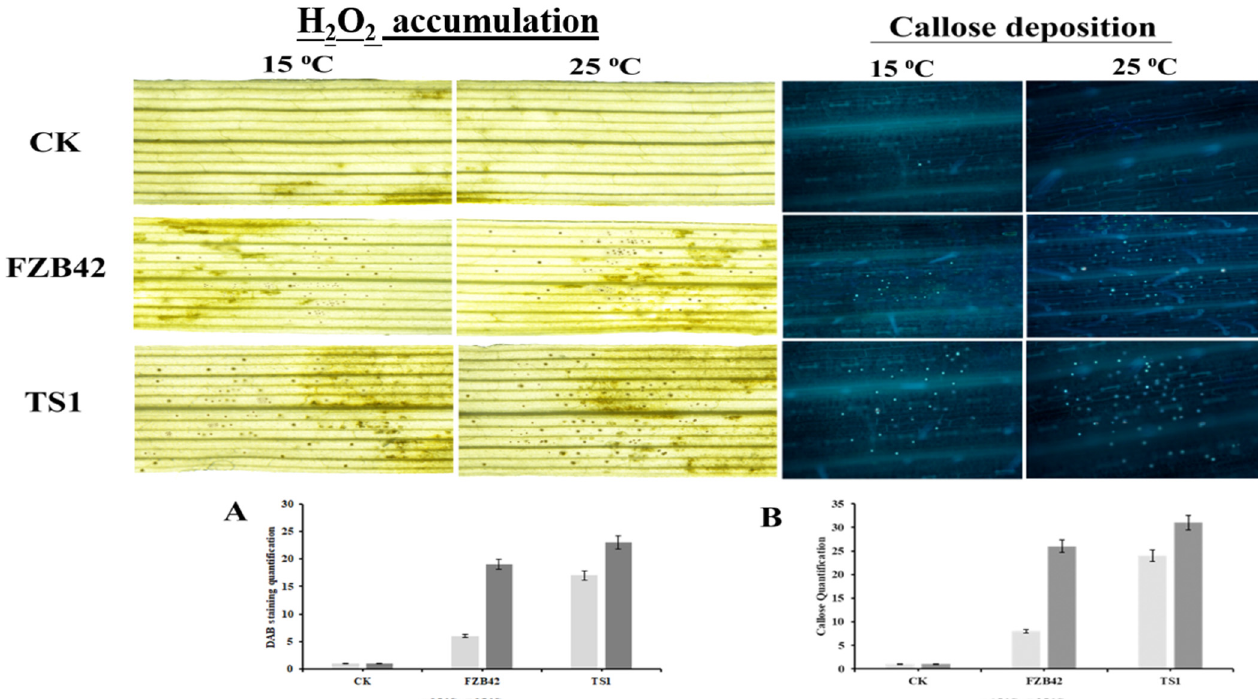
Figure 7. ( A ) The H 2 O 2 accumulation indicated by brown spots as observed by light microscopy in wheat leaves at 15 and 25 °C; the graph represents the quantification of DAB staining spots. ( B ) The callose deposition spots as observed by fluorescent microscopy in wheat leaves at 15 and 25 °C; the graph represents the quantification of callose deposition spots on wheat leaves. The data in ( A , B ) graphs are the mean calculation from 10 different photographs of each treatment. The error bars indicate the standard deviation (SD) from the mean. The significant differences between treatments were taken at p ≤ 0.05.